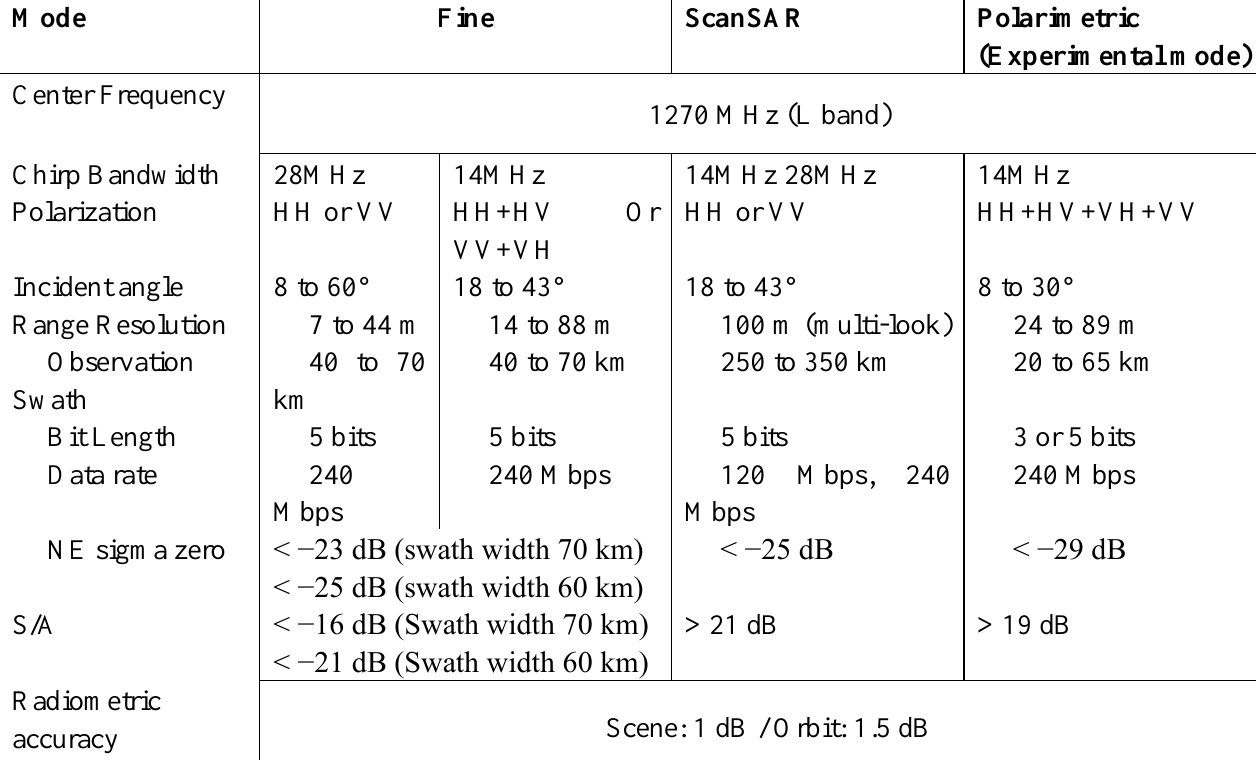
Table A1. Details of the PALSAR system